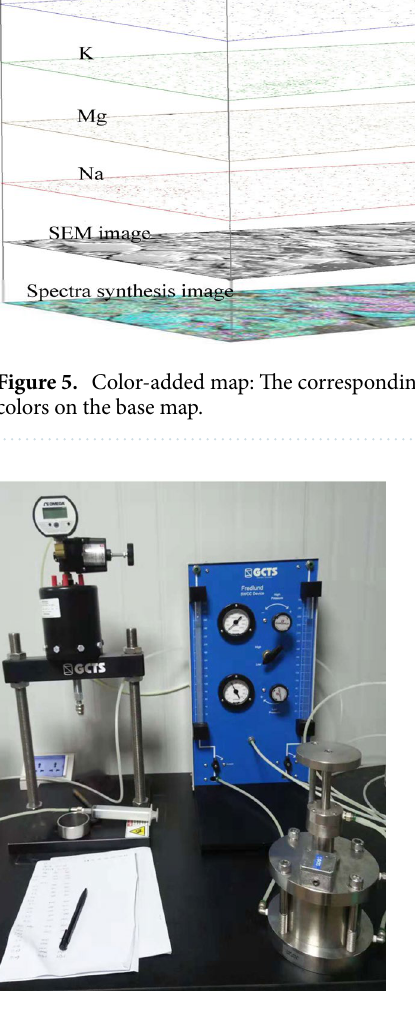
Figure 6. Soil–water characteristic pressure plate apparatus.